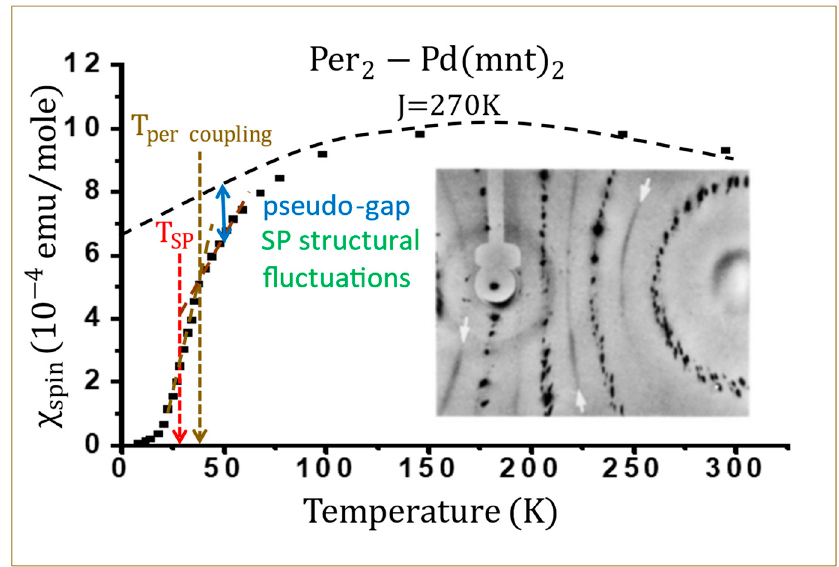
Figure 7. Thermal dependence of the spin susceptibility of Per 2 -Pd(mnt) 2 (data taken from ref. [36] and kindly provided by M. Almeida). At high temperature, χ spin behaves as the spin susceptibility of the S-1/2 AF Heisenberg Hamiltonian (1) with J = 270 K on the dithiolate stack. Below 100 K, χ spin deviates from this dependence due to the onset of SP fluctuations forming a pseudo-gap. Below 40 K (T per coupling ), the deepest rate of decrease is due to the Kondo coupling with the Per stack. The X-ray pattern in inset reveals the presence of 1D-SP structural fluctuations on the Pd(mnt) 2 stack at 40 K which are responsible for the pseudo-gap regime (see [37] for more details). The 3D SP transition achieving the condensation of diffuse lines into superstructure spots occurs at T SP = 28 K.